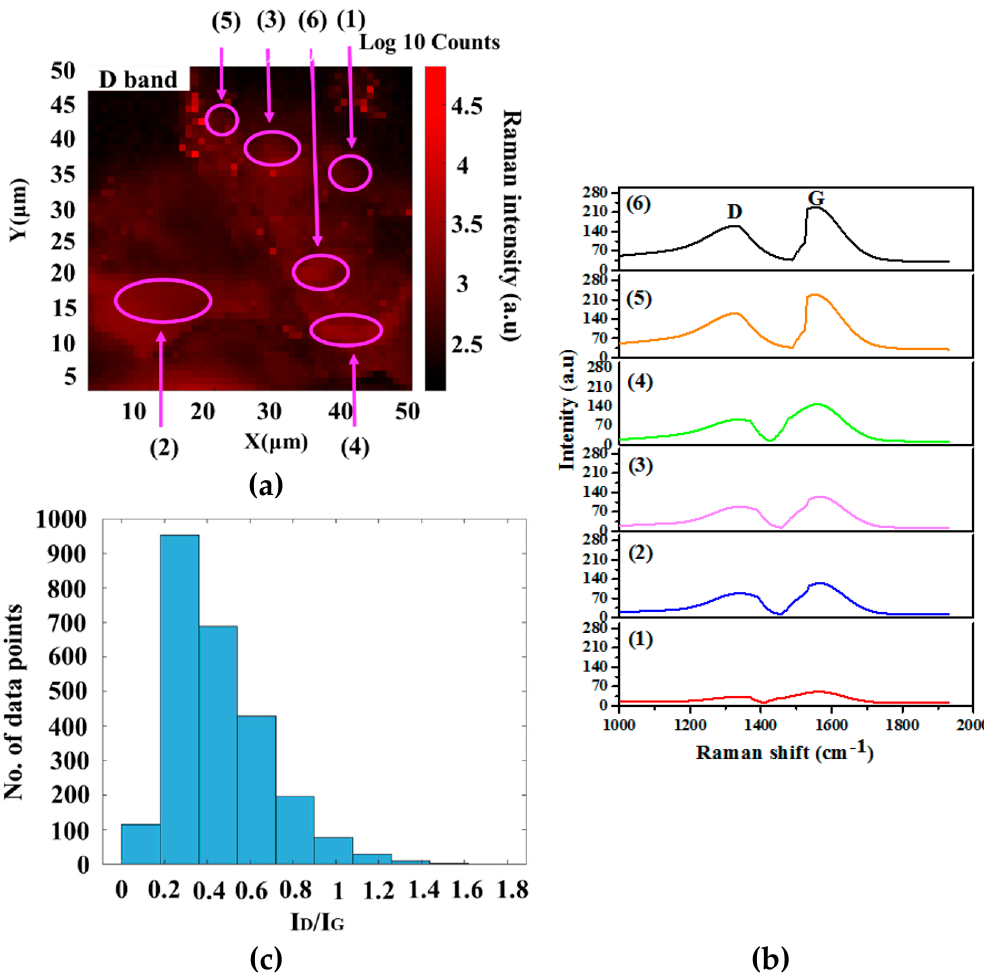
Figure 3. Raman mapping for the D band and a histogram of the I D /I G ratio of the P10% Figure 3. (a,b) Raman mapping and Raman spectra for the D band, and (c) histogram of the I D /I G ratio of the P10% sample.